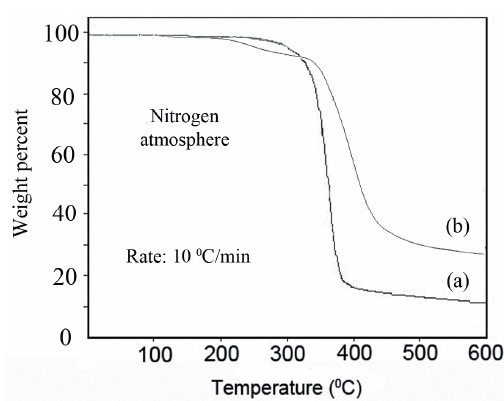
Figure 18. Schematic of the physical barrier layer forma- tion, resisting the nanocomposite against